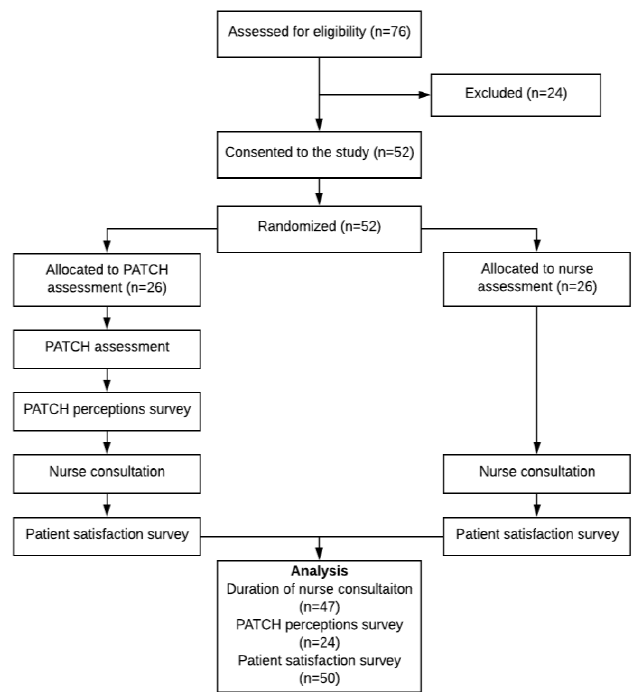
Figure 1. Flow chart detailing patient recruitment, randomization and allocation of patients to PreAnaesThesia Computerized Health (PATCH) and nurse assessments.